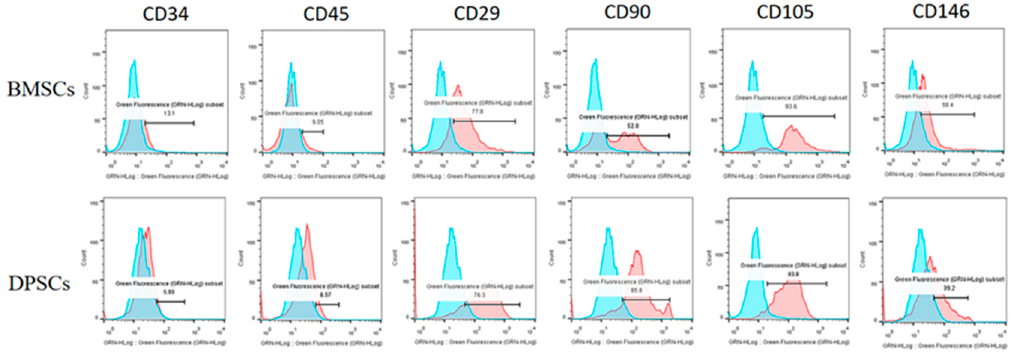
Figure 2. Characterization of surface marker profiles for BMSCs and DPSCs. The flow cytometry results revealed that the BMSCs and DPSCs were positive for CD29, CD90, CD105, and CD146, but negative for CD34 and CD45.